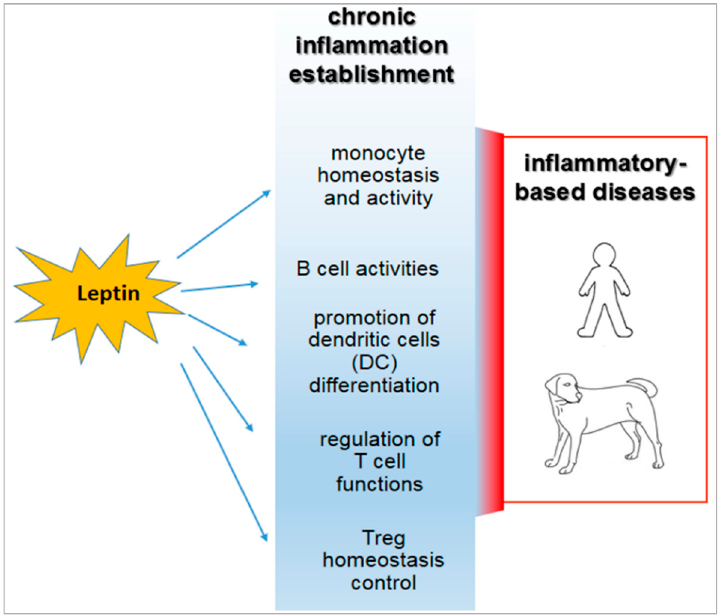
Figure 1. Inflammatory roles of leptin in the course of obesity and their relevance in both human and veterinary medicine.